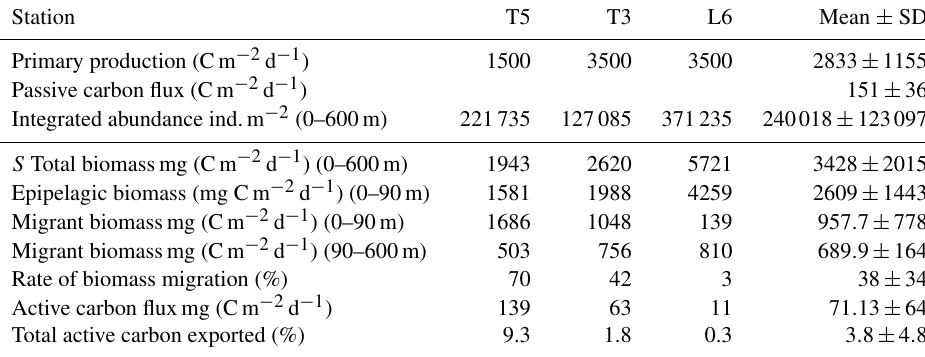
Table 5. Mean net primary production rate and estimates of daily downward C flux due to passive sinking and mediated by diel vertical migration (DVM) of mesozooplankton at three stations (T5, T3 and L6) in the coastal upwelling region off northern Chile during the austral spring 2015. Primary production represents satellite-based estimates of monthly mean (November–December 2015) at the three sampling stations. Passive C flux is a mean value estimated from sediment traps by González et al. (2000) off Antofagasta (northern Chile, 23 ◦ S) for January 1997. Total biomass and epipelagic biomass are mean observed values from day–night conditions after 2 consecutive days of